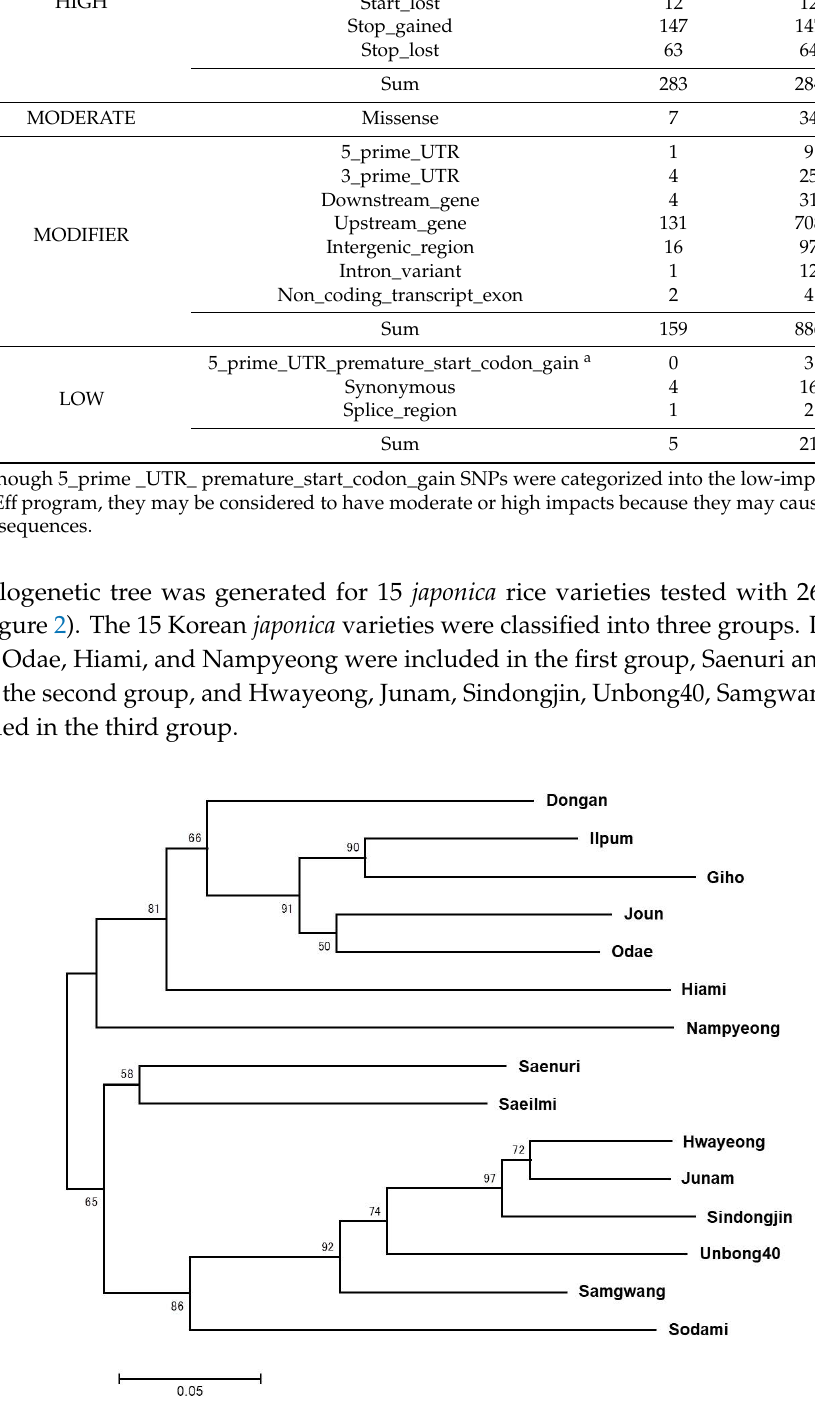
Figure 2. Phylogenetic analysis of 15 Korean temperate japonica rice varieties using genotyping data from 265 KASP markers. The phylogenetic tree was constructed using the neighbor-joining method. Numbers at the nodes indicate the percentage obtained with 1000